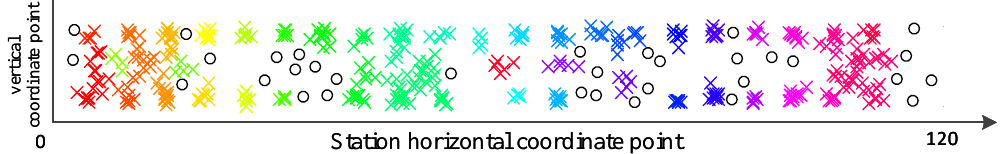
Figure 14. Improved DBSCAN algorithm for passenger location data clustering ( MinPts = 4; Eps 1 = 1.0, Eps 2 = 1.5 ) .